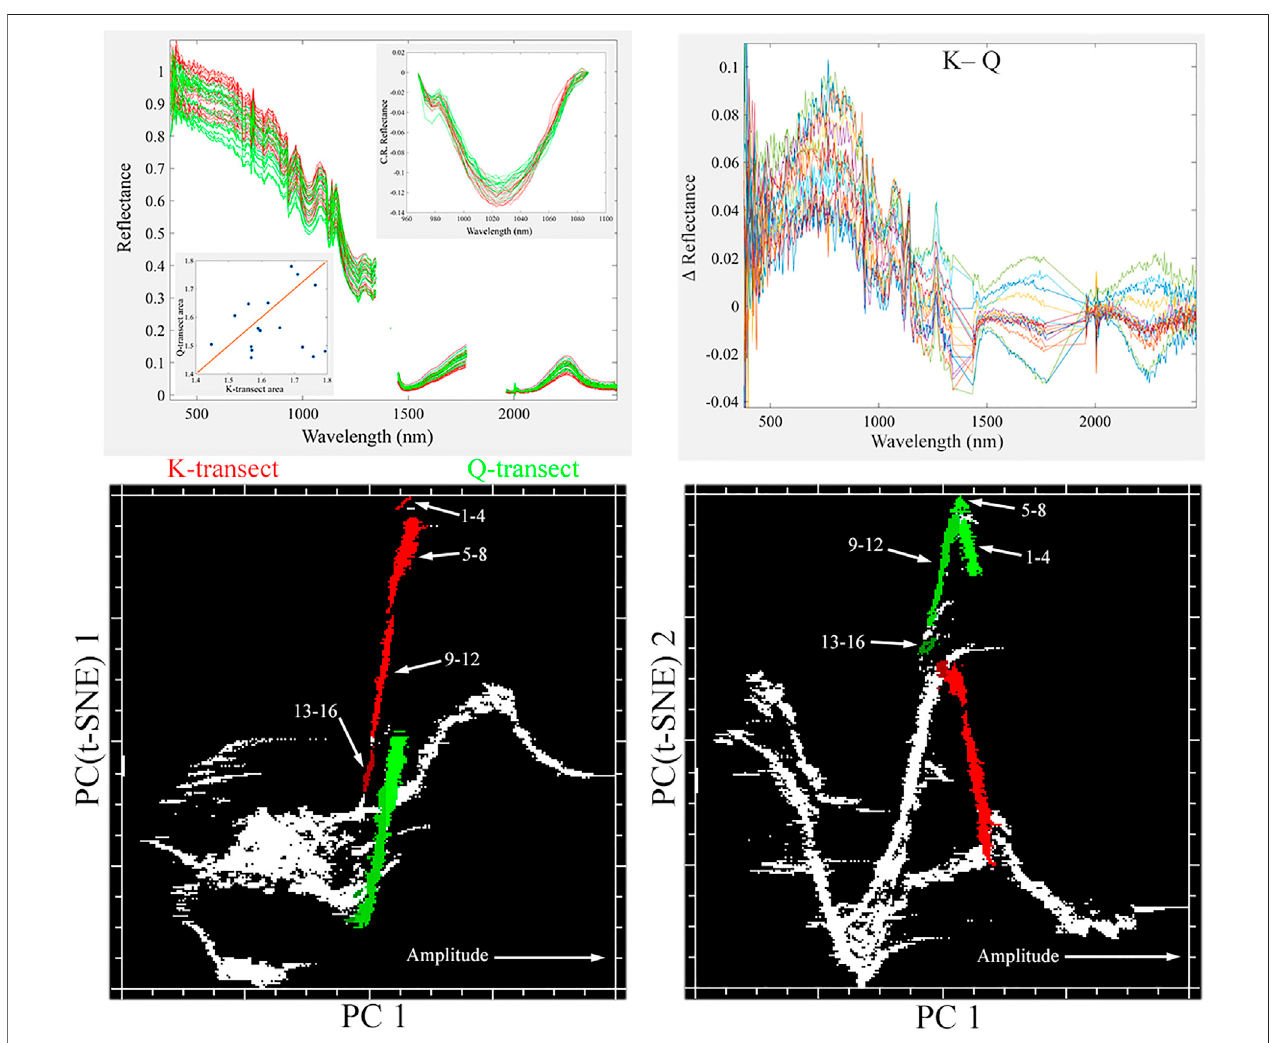
FIGURE 6 | Comparison of K and Q transect spectral continua. Distinct K and Q snow spectra span similar amplitudes and are fully comingled through the SWIR ( > 1,000 nm) with different curvature in the VNIR. Integrated areas of continuum-removed 1,030 nm absorptions (inset) are similar for sequential sets of 16 K and Q spectra, with area corresponding to grain radii ranging from 450 to 700 mm. Radii generally increase westward with decreasing spectral amplitude, but the trend is not monotonic. Distinct clusters are labeled as different shades of red (K) and green (Q), as are spectra.